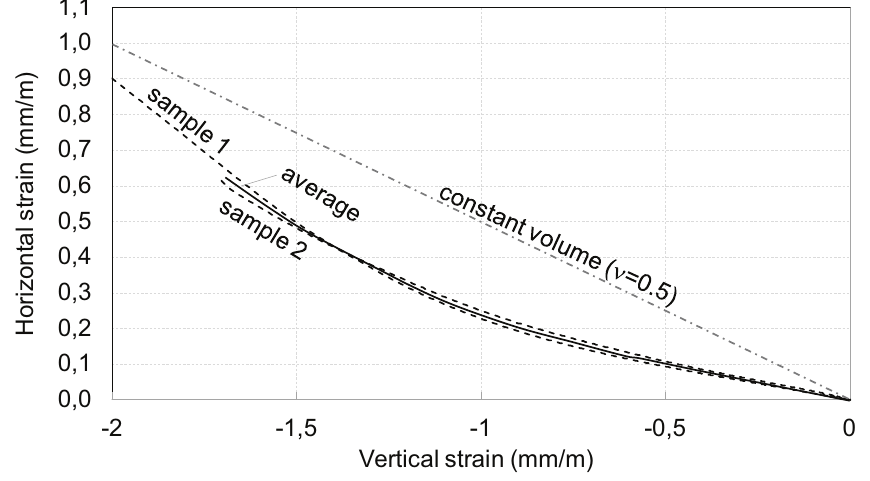
Figure 13 Horizontal and vertical strain for l/h = 1.0 Formation of conical cracks for l/h = 1.0